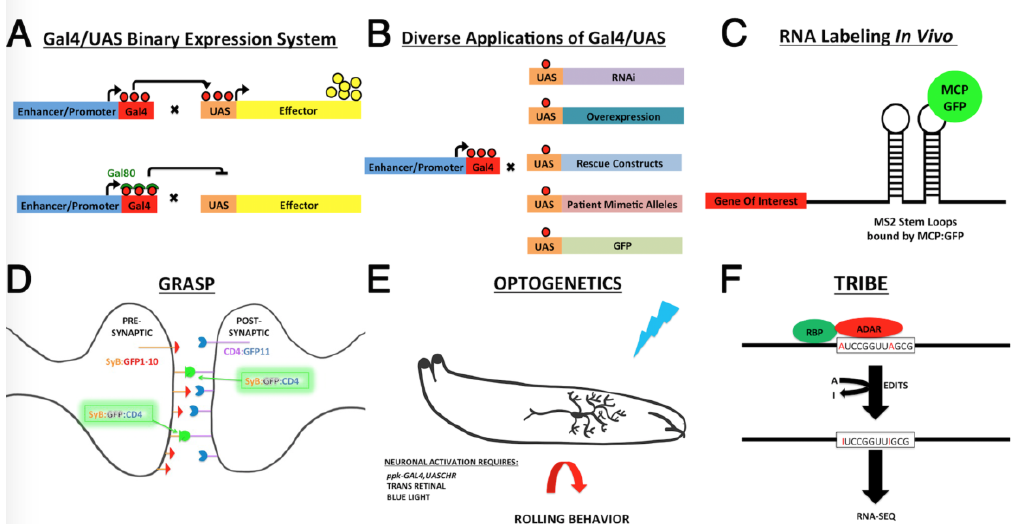
Figure 3. Tools available in Drosophila to facilitate the dissection of RBP function within the nervous system. ( A ) The Gal4/UAS binary expression system can be combined with temperature-sensitive Gal80 to control gene expression in a spatial and temporal manner. Under permissive temperatures (25 degrees Celsius) Gal80 prevents Gal4 activation of UAS . However, at restrictive temperatures (29 degrees Celsius), Gal80 is inactivated, allowing Gal4 to activate UAS constructs. ( B ) UAS-effector lines can mark cells with Grenn Fluorescent Protein (GFP), can cause overexpression of genes, RNA interference-mediated knockdown of gene expression, can assess the molecular nature of patient specific alleles, or express rescue constructs. ( C ) mRNA dynamics can be visualized within neurons of live animals using the MS2/MCP labeling system. This requires the insertion of MS2 stem loops into a gene of interest. The MS2-tagged RNA and the MS2 Coat Protein (MCP) fused to GFP are then expressed using the Gal4/UAS system. Since MCP:GFP specifically binds to MS2 stem loops, and the tagged mRNA becomes illuminated. ( D ) Synaptic partners within a neural circuit can be visualized using GRASP, which requires adjacent cells to make close contact to reconstitute GFP fluorescence from two different fragments of GFP that are tethered to the synaptic membrane (Synaptobrevin:GFP1-10 or SyB:GFP1-10 and CD4GFP). Moreover, the presence of GFP fragments within the synaptic cleft is dependent upon neuronal activity. ( E ) Functional neurons within a circuit can be assessed using optogenetic tools to activate a neuron and assess a behavioral readout, such as the ability of a larva to roll in response to the optogenetic activation of a Class IV da neuron. In this case, ppkGal4 can be used to drive expression of UASChannel rhodopsin in da neurons. Rearing animals on trans-retinal and exposing them to blue light would result in activation of these neurons and cause the larva to roll. ( F ) “targets of RNA-binding proteins identified by editing” (TRIBE) allows researchers to identify target RNAs of a specific RBP in a tissue specific manner by leaving A to I edits within the RNA, which can later be identified through sequencing and bioinformatics. For such experiments, an RBP is fused to the editing domain of the ADAR protein, allowing the RBP to bind to its endogenous RNA targets but leave A to I edits near the binding site though the catalytic ADAR domain.